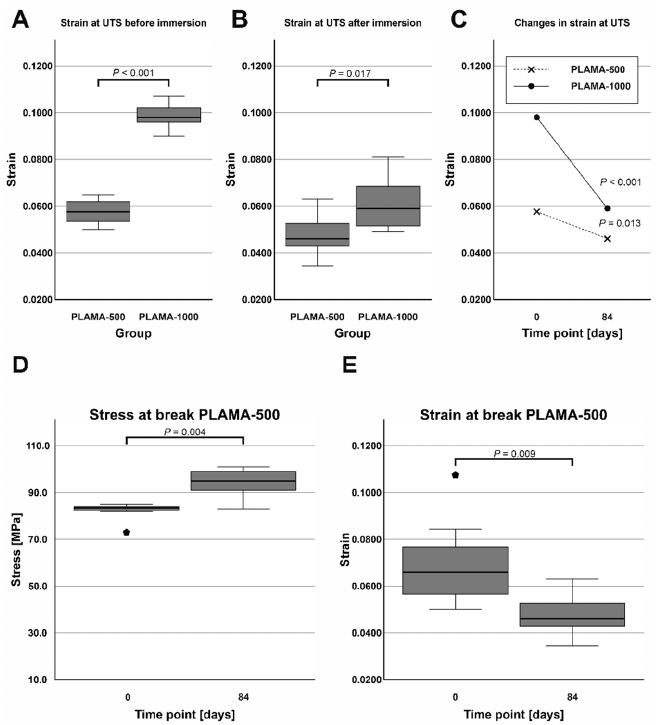
Figure 14. Comparison of the strain at ultimate flexural strength of PLAMA-500 and PLAMA-1000 before and after the SBF immersion test ( A , B ); changes in the strain in both groups ( C ); changes in the stress at break ( D ) and the corresponding strain ( E ) in PLAMA-500.